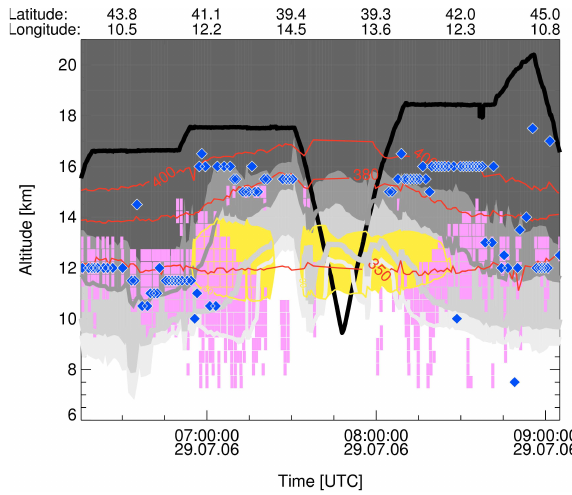
Fig. 8. Grey shadings show the ECMWF potential vorticity at 1.5, 2, 4 and 6PVU, black line the flight track. Red contour show ζ -level from CLaMS, blue diamonds show the thermal tropopause from CRISTA-NF measurements, and the filled yellow contour shows 30ms − 1 the horizontal wind speed from ECMWF. Pink rectangles show positions, where the tracer-tracer correlation in Fig. 7c indi- cates